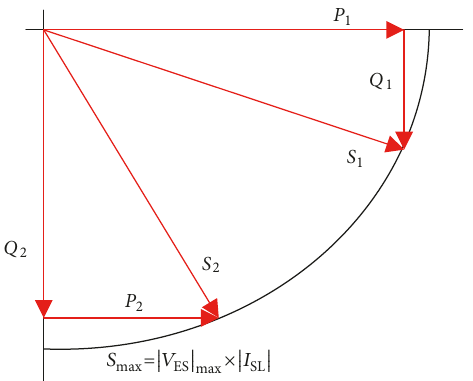
Figure 3: Illustration of power compensation by the ES.